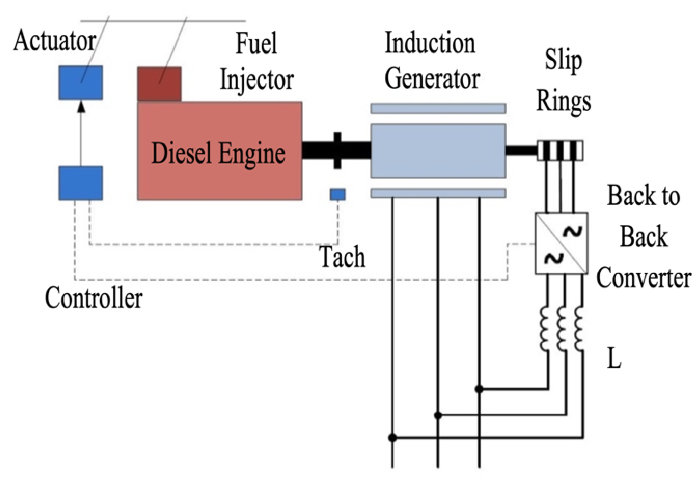
Figure 3. Variable speed diesel engine with DFIG [14] .